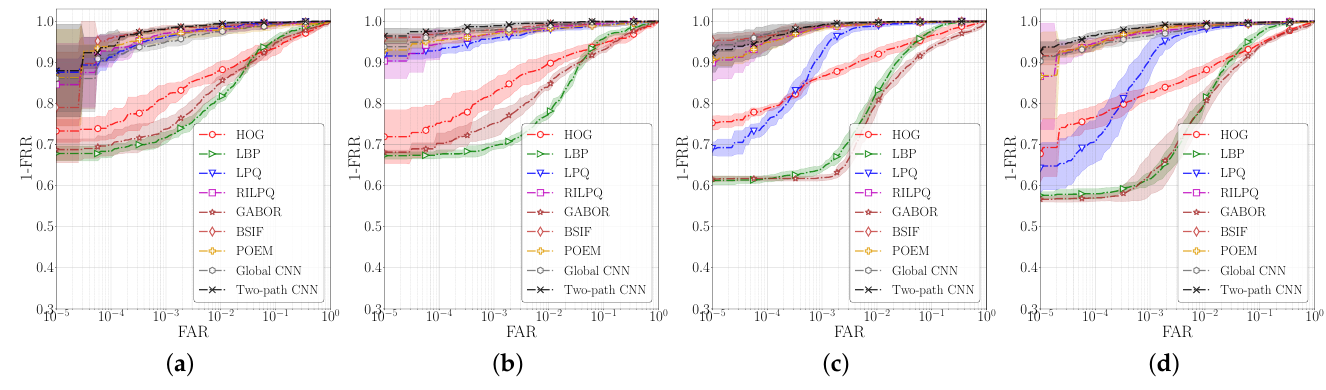
Figure 9. Comparison between the traditional feature extraction methods and the proposed two-path model evaluated on the ( a ) left and ( b ) right palmprints from the IITS dataaset, as well as the ( c ) left and ( d ) right palmprints of the CASIA dataset. The figure shows average ROC curves together with σ ) on a semilog scale. confidence intervals (in the form µ ± Table 3. Comparison against traditional recognition approaches relying on hand-crafted features. Results are reported for left and right palms separately for both datasets. The results are presented in σ (and in (%)) computed over five test subsets. The best performance is highlighted the form of a µ ± in